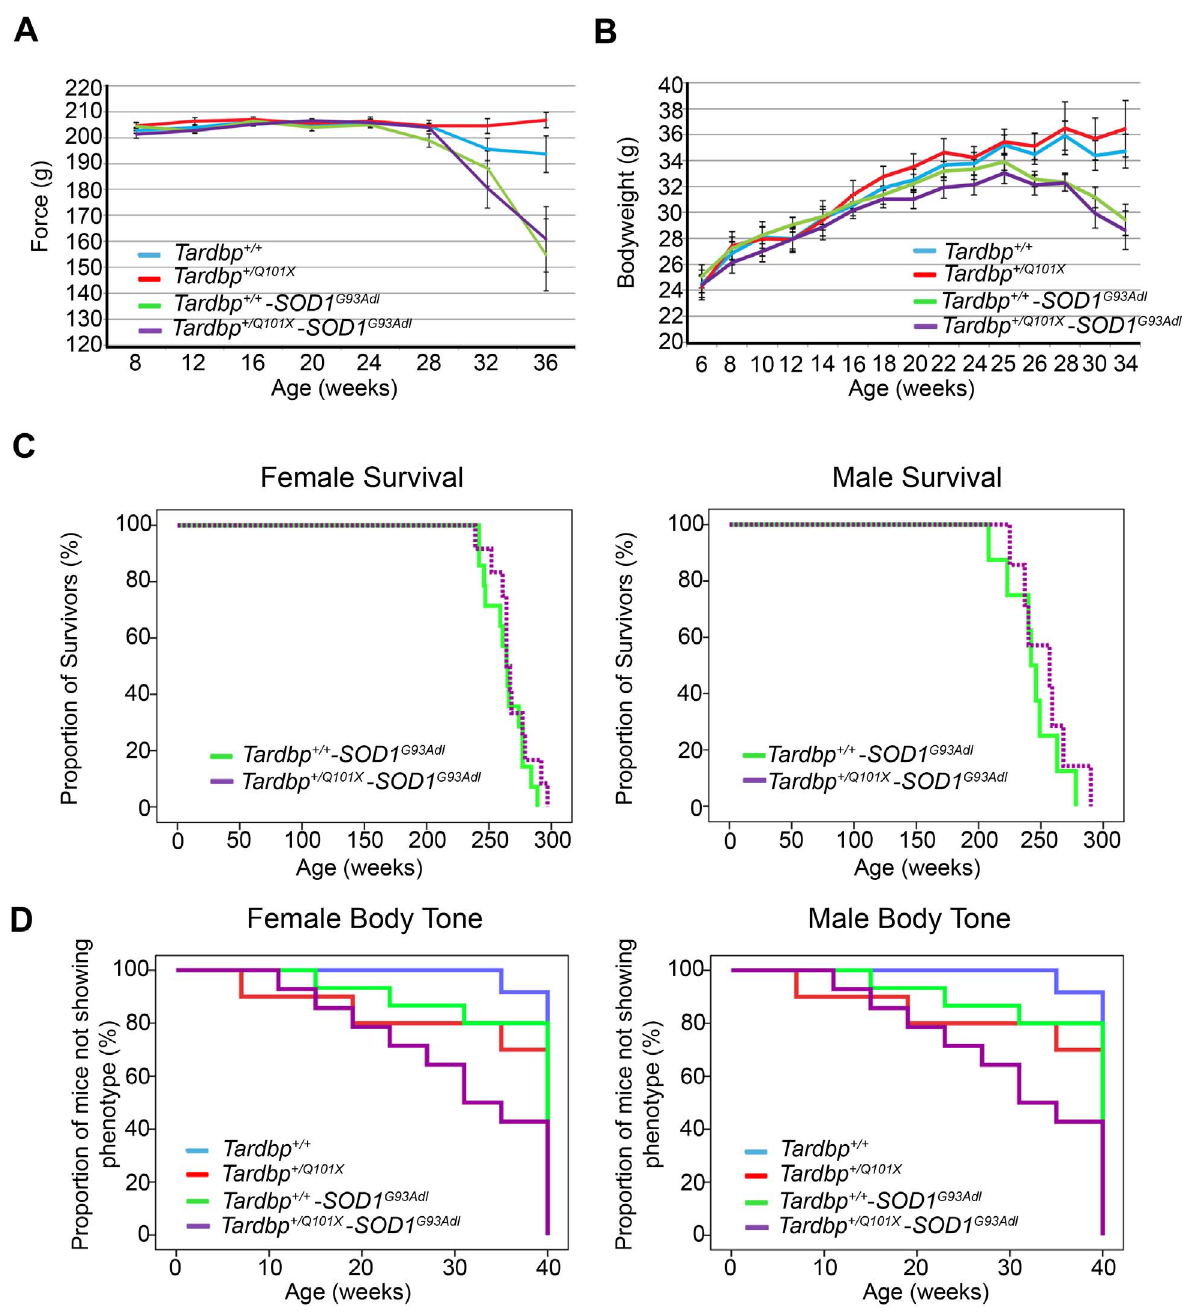
Figure 5. No interactive effects between Tardbp + /Q101X and SOD1 G93Adl mice. ( A ) Grip strength of SOD1 G93Adl mice (both sexes) is not affected by the Q101X mutation in Tardbp . SOD1 G93Adl mice show progressive loss of grip strength (versus Tardbp + / + p=0.002, LSD test from one-way ANOVA), however there is no difference between Tardbp + / + , SOD1 G93Adl and Tardbp + /Q101X , SOD1 G93Adl mice (p . 0.05). Data are mean 6 SEM. ( B ) Progressive bodyweight loss in SOD1 G93Adl mice is not affected by the Q101X mutation in Tardbp . Data are mean 6 SEM. ( C ) Survival plots for female (left panel) and male (right panel) mice show no effect of the Q101X mutation on survival of SOD1 G93Adl mice. Endstage was defined as humane end-point or greater than 20% weight loss. Tardbp + / + , SOD1 G93Adl 256 6 4 days n=22, Tardbp + /Q101X , SOD1 G93Adl 263 6 8 days n=19 (total number including both sexes, with equal ratio), p=0.227 (Kaplan Meier log rank statistic) ( D ) Body tone phenotype of Tardbp + /Q101X is replicated but not significantly different in Tardbp + /Q101X , SOD1 G93Adl mice (female mice: left panel; male mice: right panel). Mean age at which body tone phenotype was shown for both sexes combined: Tardbp + / + =absent, Tardbp + /Q101X =32 weeks of age (more than 50% of females), Tardbp + / + , SOD1 G93Adl =absent, Tardbp + /Q101X , SOD1 G93Adl n=26 weeks (50% for both sexes). Tardbp + / + , SOD1 G93Adl versus Tardbp + /Q101X , SOD1 G93Adl p=0.042, Tardbp + /Q101X versus Tardbp + /Q101X , SOD1 G93Adl p=0.982, Tardbp + / + versus Tardbp + /Q101X p=0.006 (Kaplan Meier log rank statistic). Overall p=0.008, with no significant difference between sexes within genotypes. Female mice: Tardbp + / + n=10, Tardbp + /Q101X n=5, Tardbp + / + , SOD1 G93Adl n=14, Tardbp + /Q101X , SOD1 G93Adl n=14. Male mice: Tardbp + / + n=12, Tardbp + /Q101X n=10, Tardbp + / + , SOD1 G93Adl n=15, Tardbp + /Q101X , SOD1 G93Adl n=14.